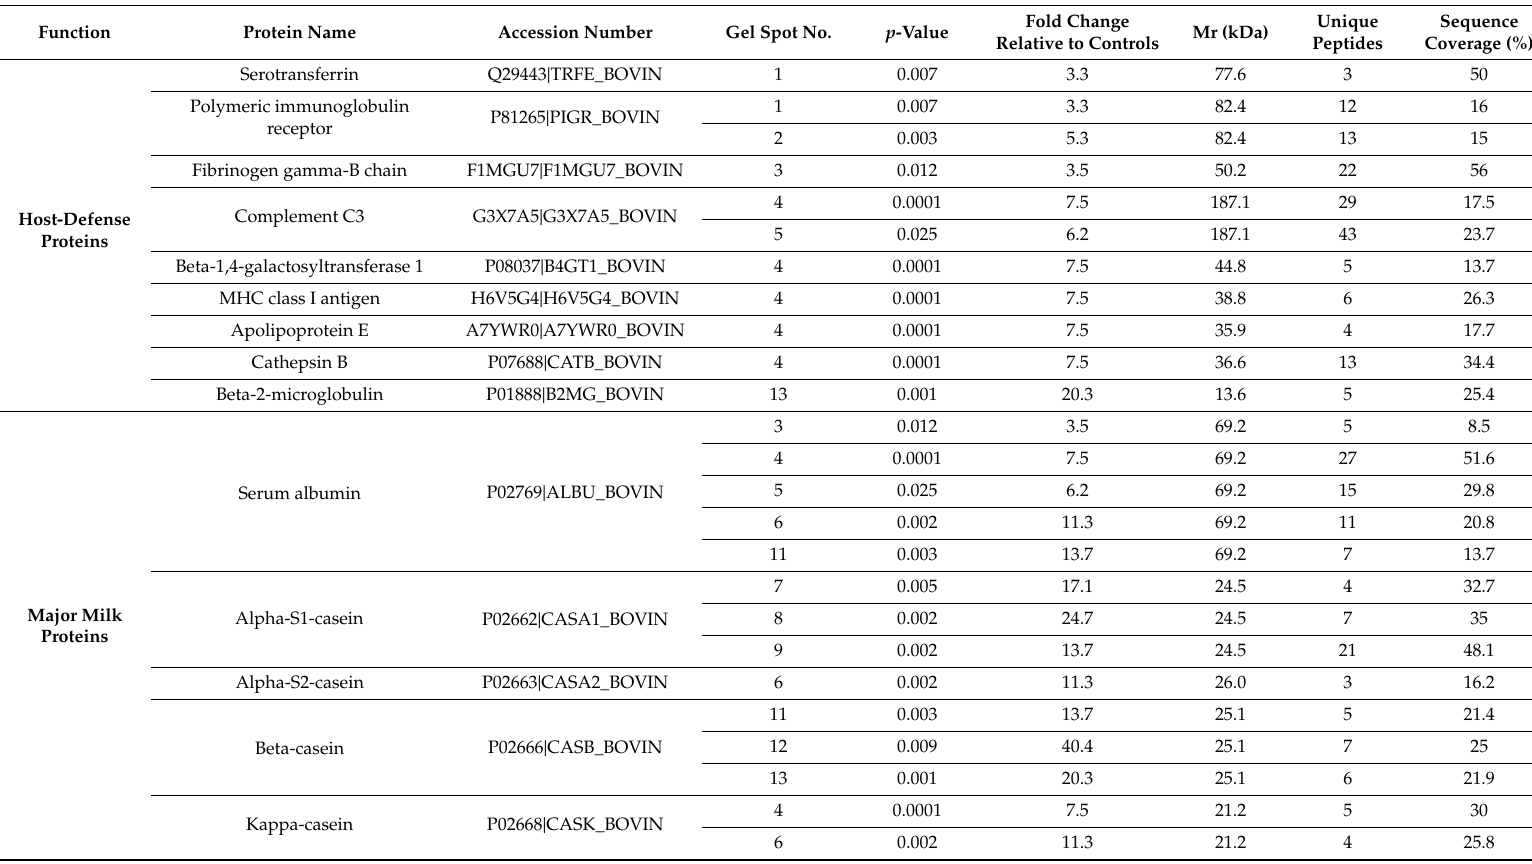
Table 1. List of proteins identified by 2D-DIGE / liquid chromatography–tandem mass spectrometry (LC–MS / MS) analysis that are highly abundant in milk from cows with subclinical Staphylococcus aureus